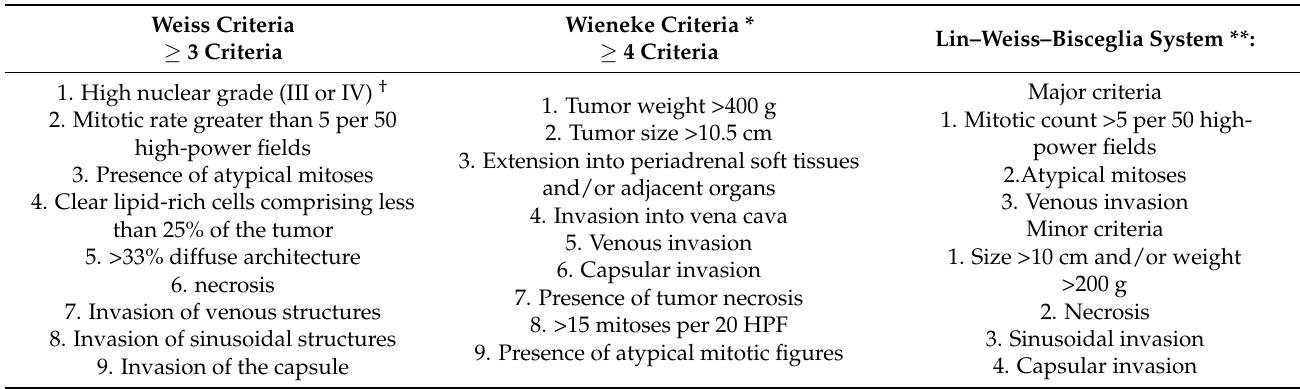
Table A1. Diagnostic criteria/scoring in differentiating malignant from benign adrenocortical lesions [42,121,123,234]. Weiss Criteria ≥ 3 Criteria